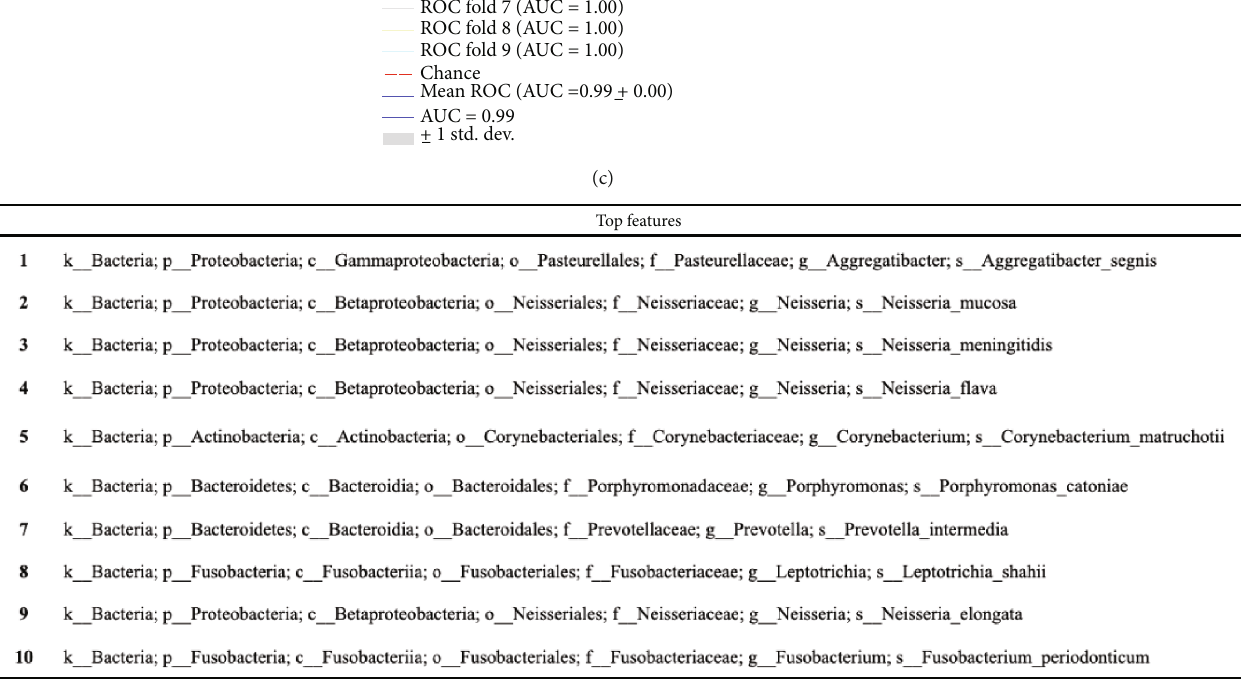
Figure 3: Identi fi cation of microbiota-based biomarkers for stroke. (a) Cladograms generated from LEfSe. (b) LDA scores for the di ff erentially abundant bacterial taxa ( LDAscore > 3 : 5 ). Red bars indicate taxa enriched in the poststroke group; green bars indicate taxa enriched in the control group. (c) ROC analysis for random forest model. (d) List of 10 discriminant bacterial taxa based on random forest model. LDA: linear discriminant analysis; ROC: receiver operating characteristic curve; AUC: area under the